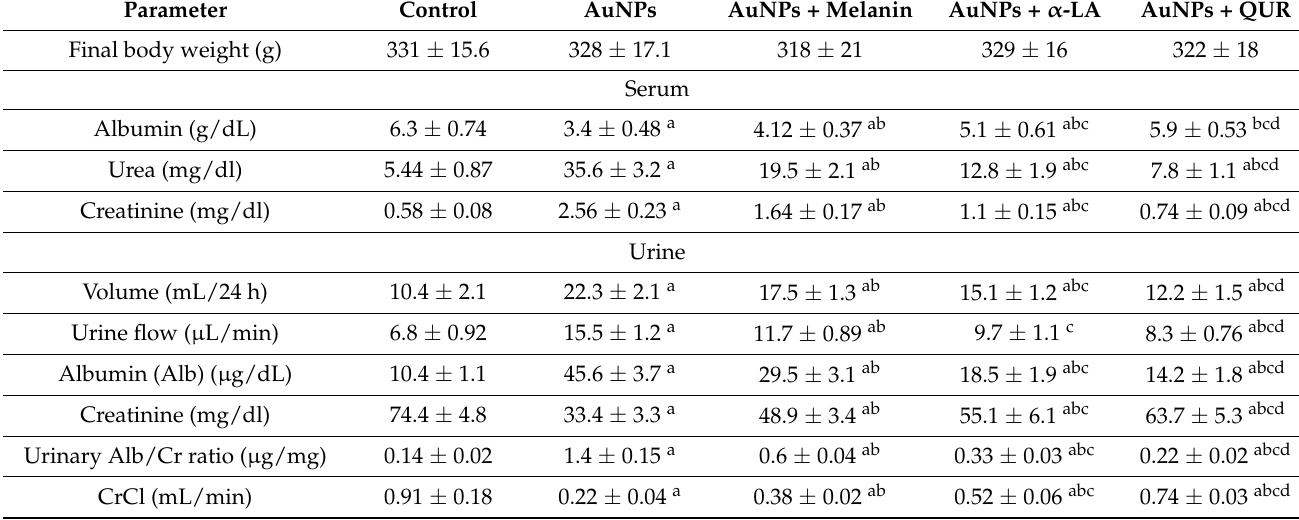
Table 1. The effects of AuNPs with or with treatment with melanin, α -lipoic acid ( α -LA), and quercetin (QUR) on food intake and kidney function markers in all groups of